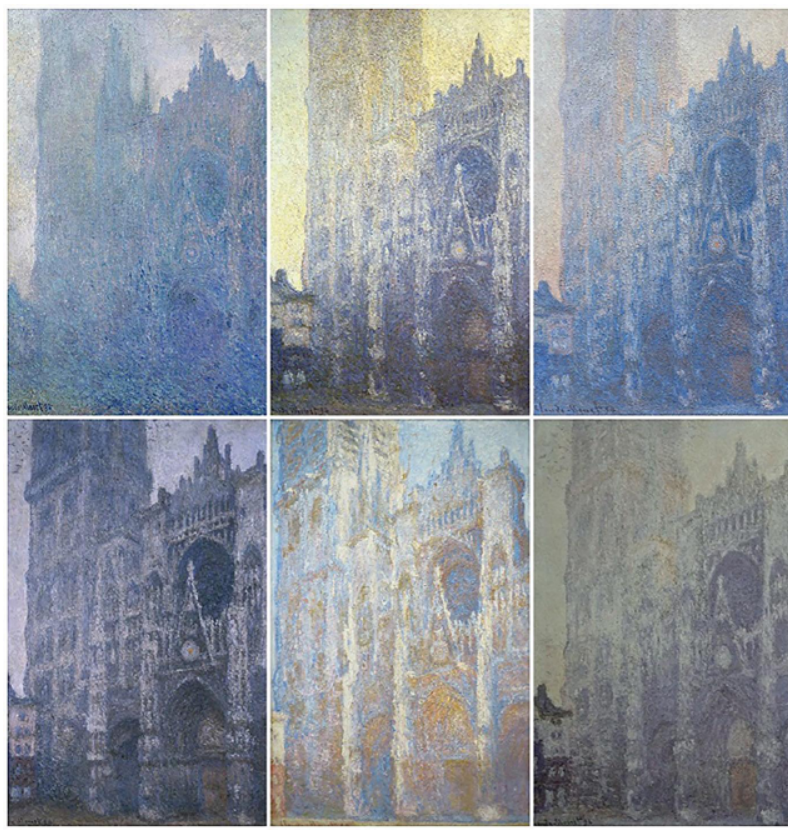
Claude Monet’s last paintings depicting Rouen Cathedral, 1894 series. Source: